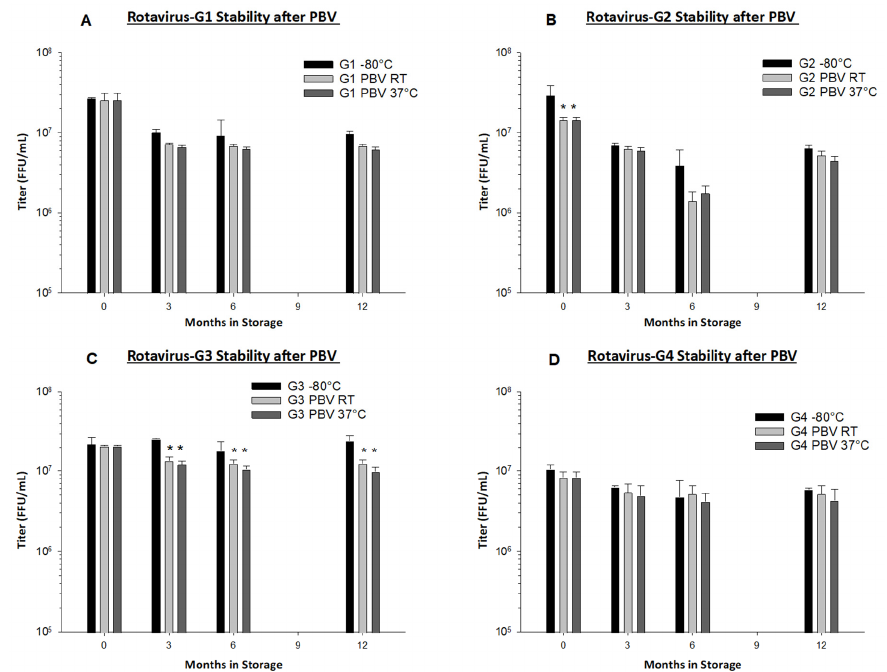
Figure 4. Long-term stability of preservation by vaporization (PBV) live rotavirus vaccines G1 ( A ), G2 ( B ), G3 ( C ) and G4 ( D ) at different temperatures was tested via immunoperoxidase focus-forming assay on MA104 cells. PBV provided high long-term stability and viral recovery for individual rotavirus vaccine strains after 1 year of storage at room temperature (RT) and 37 ◦ C in the dry carbohydrate foam format. Samples of PBV vaccines stored at RT (22 ± 3 ◦ C) and 37 ◦ C were tested at initial yield (0 month), three months, six months, and 12 months in comparison to liquid control vaccine stored at − 80 ◦ C. Asterisk (*) indicates significance ( p < 0.05) between test group and − 80 ◦ C control (two-way ANOVA). Less than 0.5 logs loss in measured titer was observed in all groups in comparison to − 80 ◦ C control vaccine, even groups where significance was